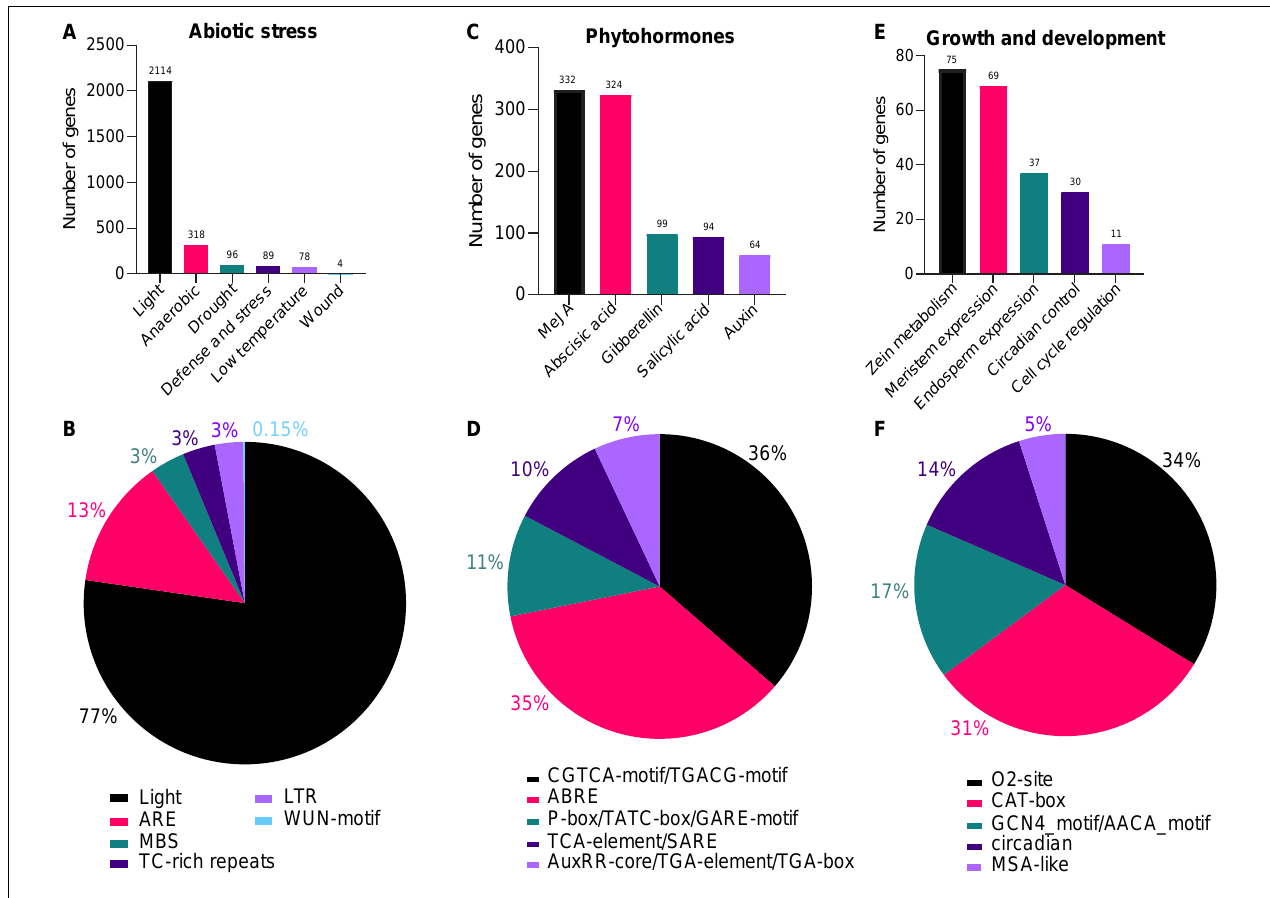
FIGURE 7 | Cis -regulatory elements in the AhAPX promoter regions. (A,C,E) The total number of AhAPX genes involved in abiotic stress, phytohormones, and growth and development categories of cis -elements. (B,D,F) The percentage (%) ratio of the several cis -elements from each category is shown in pie charts, i.e. (B) abiotic stress-responsive, (D) phytohormones responsive, and (F) plant growth and development responsive. Diverse colors signify different cis -acting elements and their ratio present in AhAPX